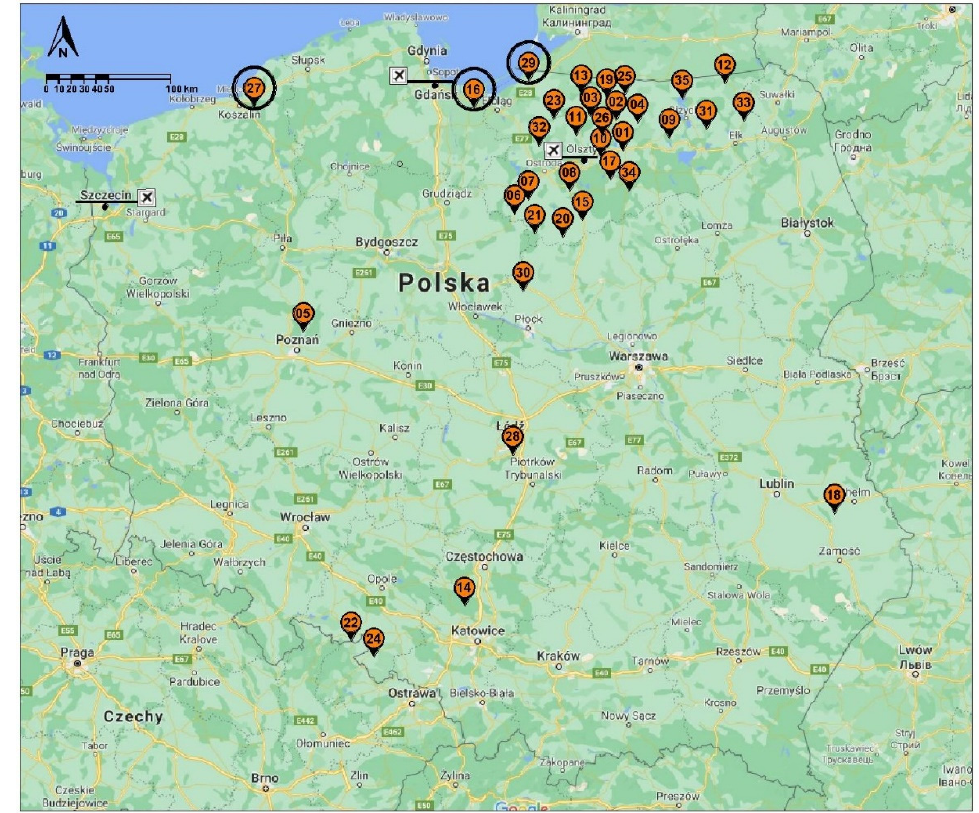
Figure 1. Location of Polish coastal Cittaslow towns: (16) Nowy Dwór Gda ń ski, (27) Sianów, and (29) Braniewo.